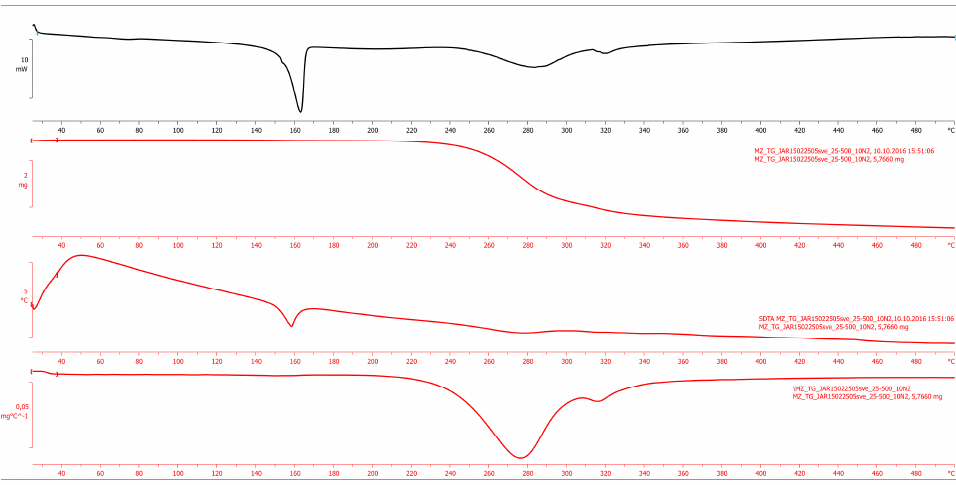
Figure C4. DSC, TG, SDTA and DTG curves of pOHsaladpm .